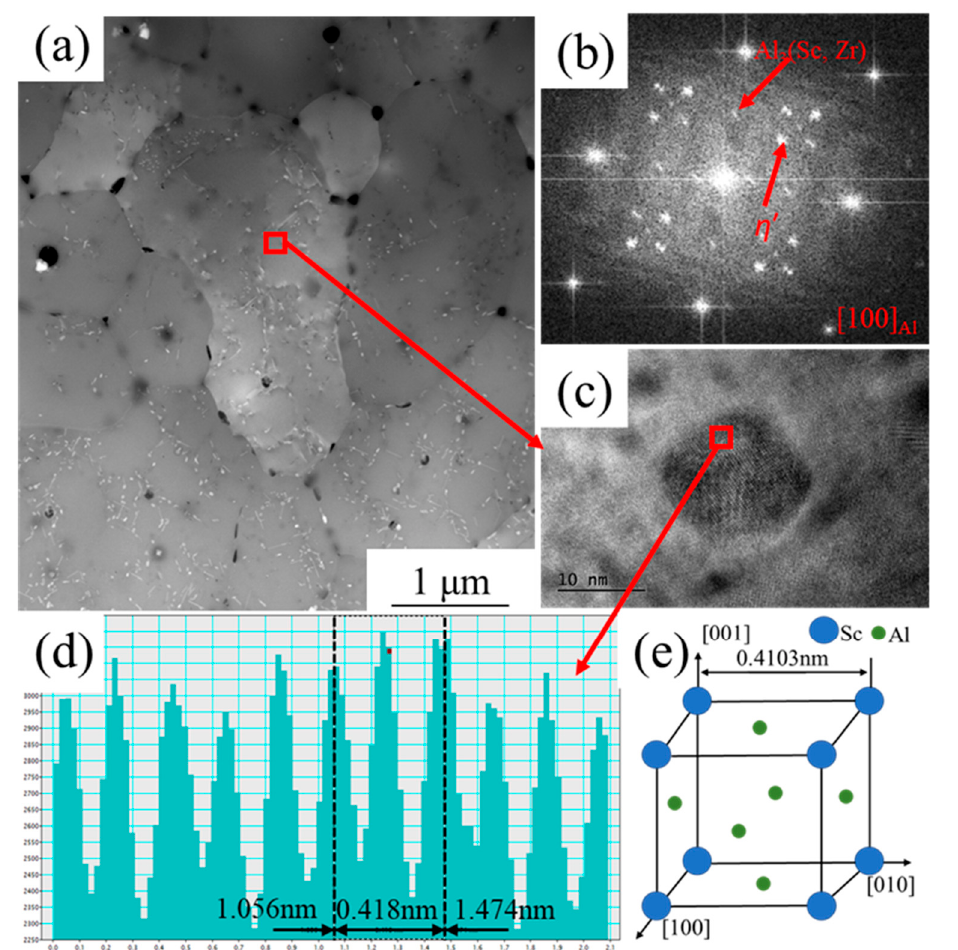
Figure 9. The TEM analysis of sample 4 in the as-printed status, ( a ) BT-TEM, ( b ) FFT of ( c ), ( c ) HRTEM, ( d ) interatomic distance measurement results, ( e ) schematic diagram of the lattice of Al 3 Sc